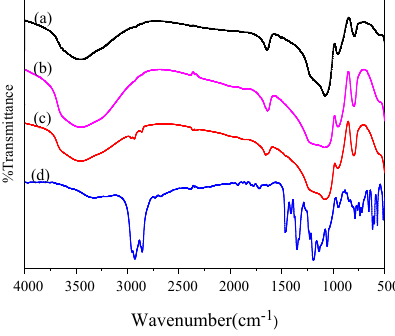
Figure 2. FTIR spectra of SiO 2 -H ( a ), SiO 2 -C ( b ), Si-P 8 TFSI / SiO 2 -H(I) ( c ), and neat ionic liquid (IL) ( d ). As shown in Figure 2, the infrared spectrum of Si-P 8 TFSI / SiO 2 -H(I) shows the appearance of the bands at 2924 cm -1 and 2856 cm -1 due to C-H aliphatic stretching vibration, and the peak at 1465 cm -1